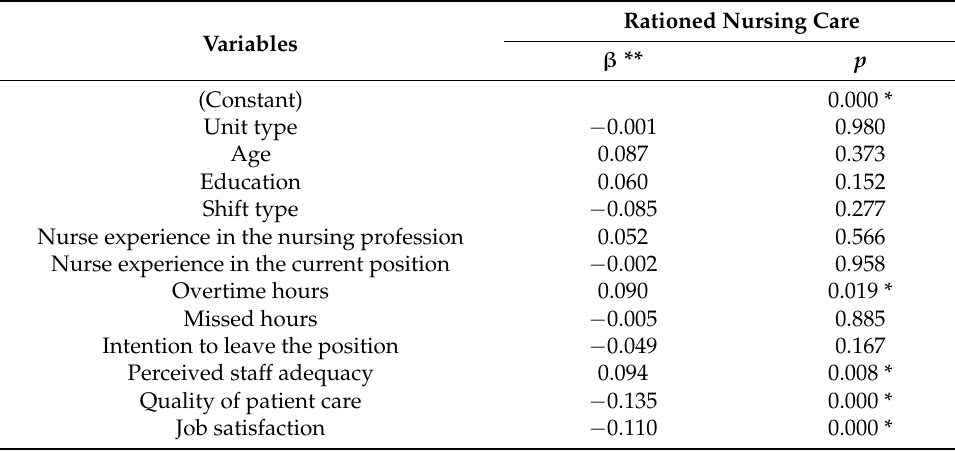
Table 3. Predictors of rationed nursing care among Slovak